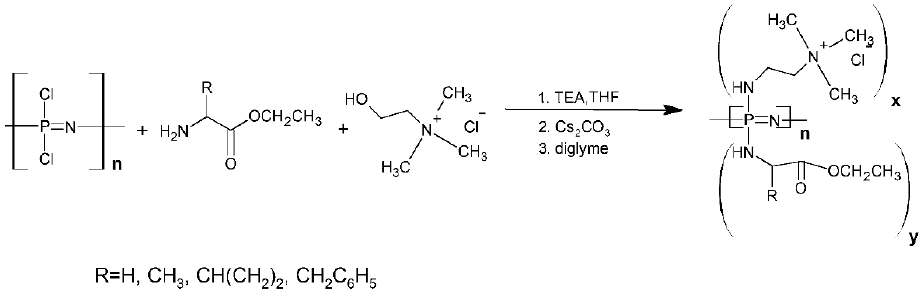
Figure 22. H-bonds between polymeric chains in polyphosphazene–PLAGA blends.